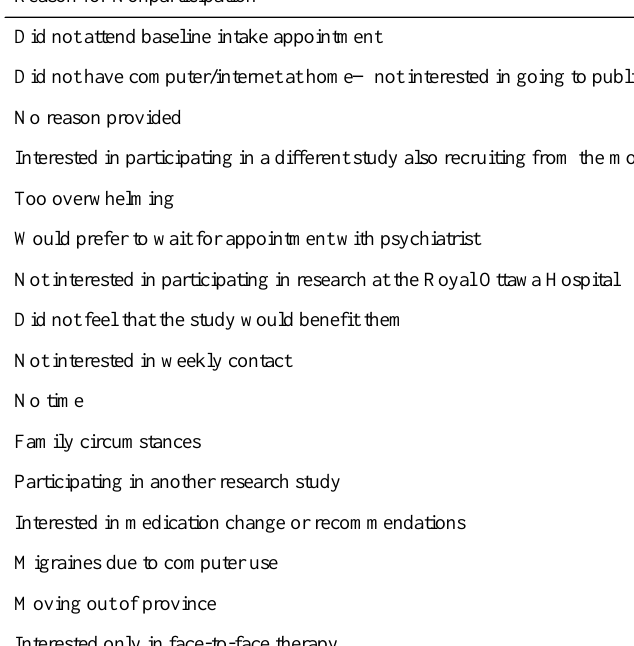
Table 4. Reasons for nonparticipation